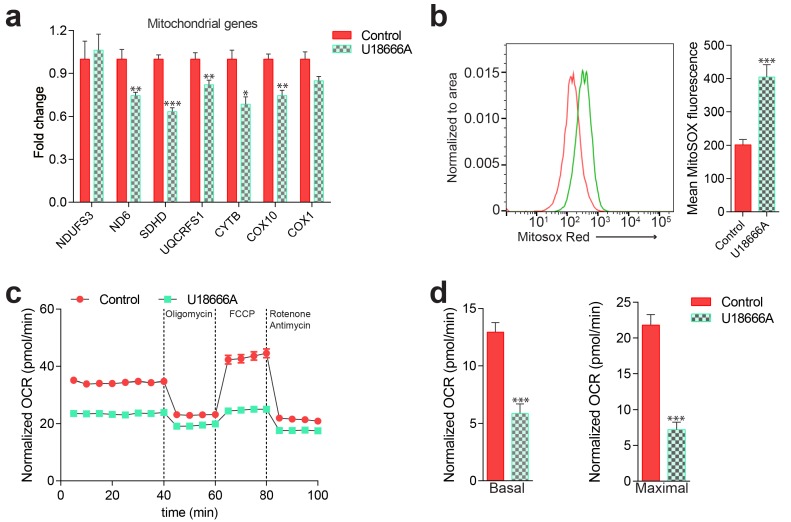
Mitochondrial deficits in control fibroblasts treated with U18666A 10 µM for 72 hr (inhibitor of NPC1).(a) Mitochondrial gene expression levels in U1866A treated cells shown as mean ± s.e.m., n = 3. T-test p-values *p<0.05 **p<0.01 ***p<0.001. DMSO used as vehicle control. (b) Increased mitochondrial superoxide levels, as assessed by MitoSox intensity, in U18666A-treated cells quantified as mean ± s.e.m., n = 5. T-test p-values ***p<0.001 (c–d) Decreased Oxygen consumption rate (OCR) in U18666A-treated fibroblasts under the indicated conditions, quantified in panel d) as mean ± s.e.m. n = 2, with eight technical replicates. DMSO used as vehicle control.